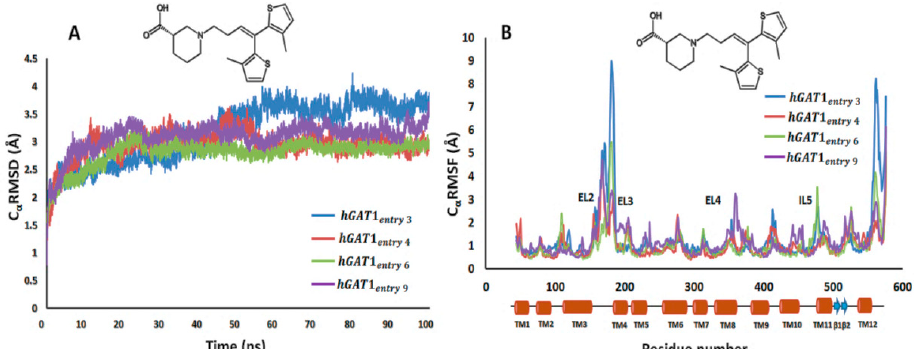
Figure 4. 100 ns MD simulations of selected tiagabine enantiomers. ( A ) hGAT1 entry 6 and hGAT1 entry 4 enantiomers showed the lowest C α RMSD (approx. 2.5 Å) as compared to the entries 3 and 9 of Table 1.